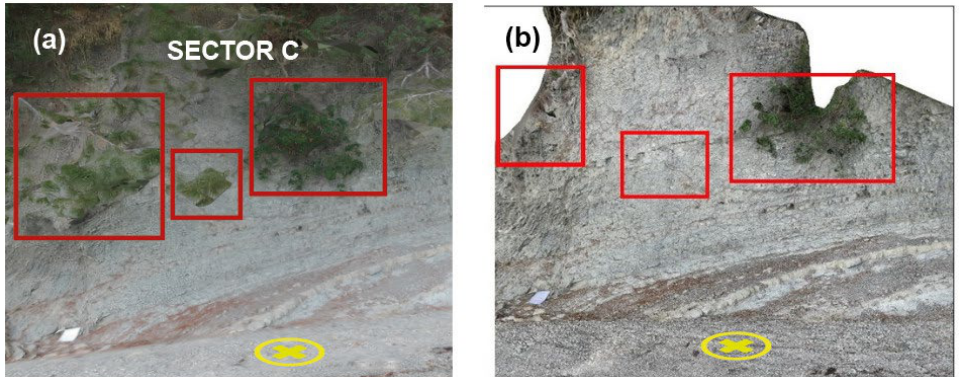
Figure 13. Comparison of photogrammetric models of a sea cliff stretch covered by vegetation: ( a ) 3D model obtained by UAV-derived data; ( b ) 3D model obtained by MP-derived data. Note the differences in the same areas of the outcrop (red squares). The location of the GCPs (yellow encircled crosses) is also shown.